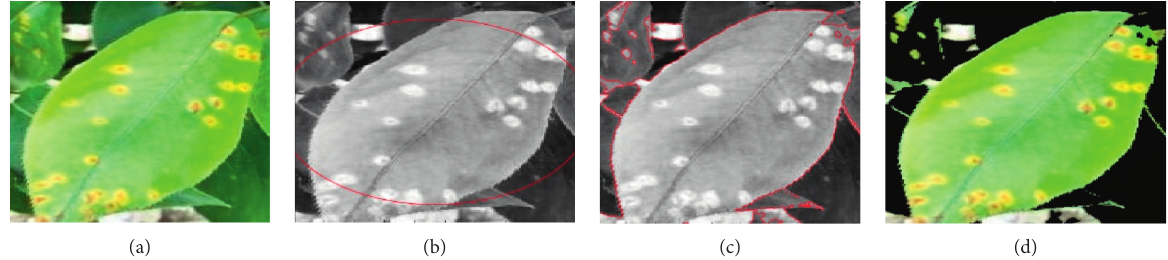
Figure 5: The result of Chan–Vese algorithm segmenting rust diseased leaf: (a) image capture; (b) initial zero level set; (c) contour image after 500 iterations; (d) segmentation